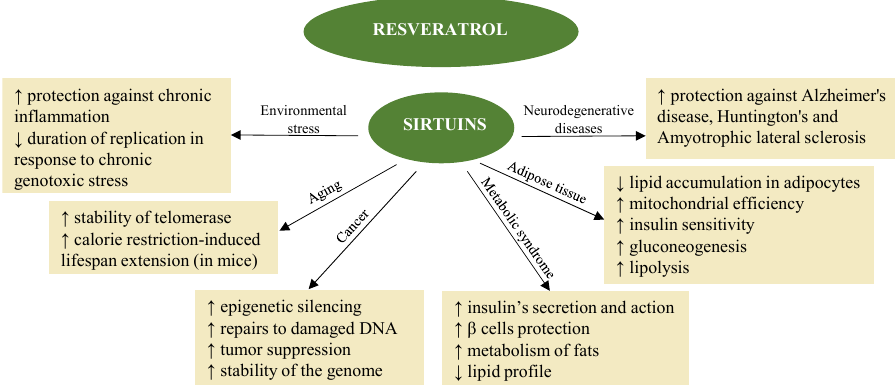
Figure 2. Resveratrol exerts different effects by activating sirtuin [4].